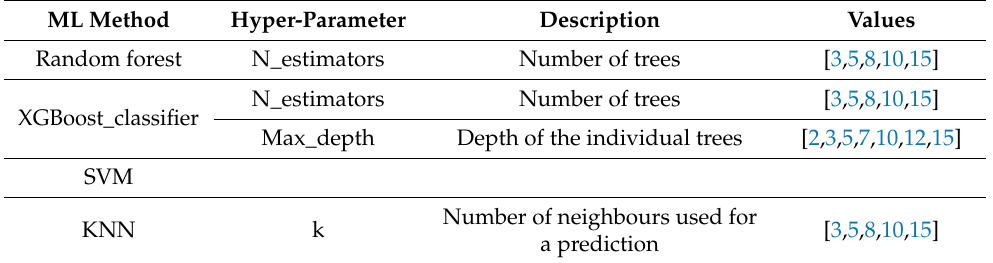
Table 2. Tested ML methods and hyper-parameters with ranges used during